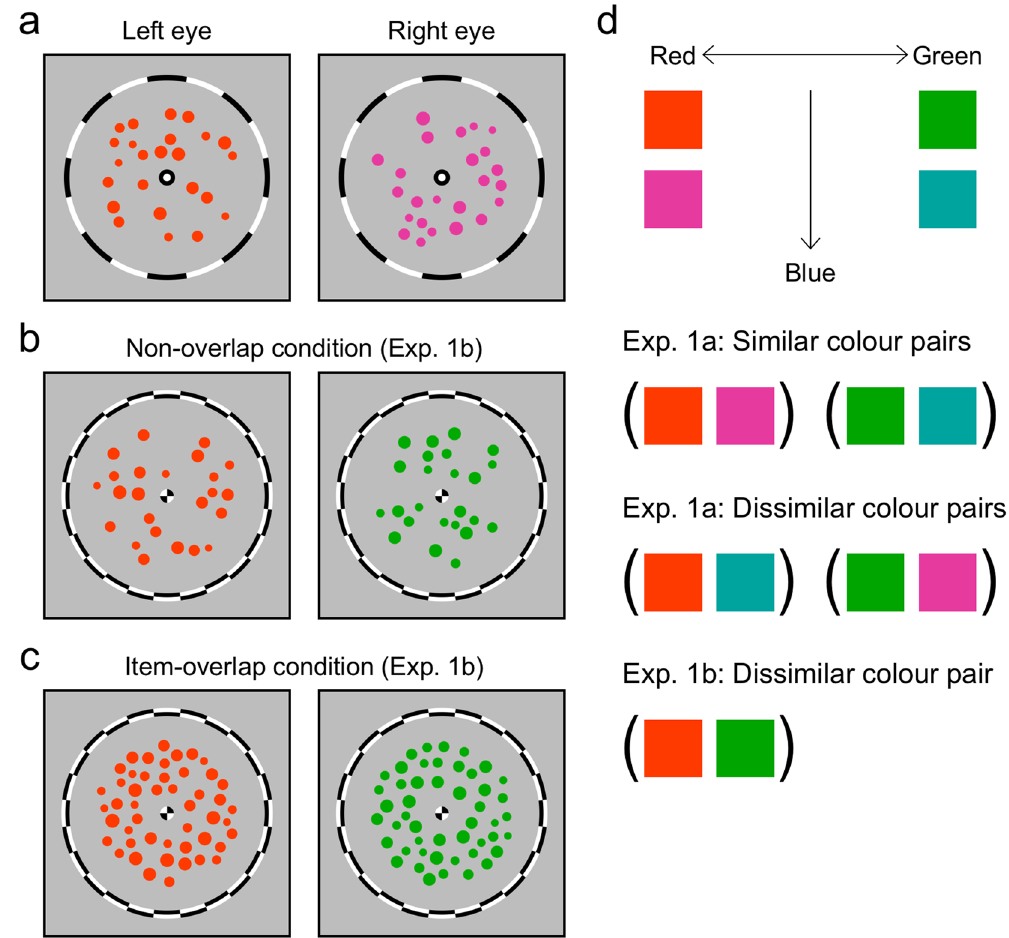
Figure 2. Example stimuli used in Experiment 1a are shown in ( a ), example stimuli of the non-overlap condition in Experiment 1b are shown in ( b ), and the item-overlap condition in ( c ). The colours of the circles in this figure are chosen to give a similar sense as the colours used in Experiments 1a and 1b. In the real Experiments, each participant adjusted colours so that they were subjectively equiluminant. We used two colours in the pure red-green scale and the other two colours made by adding a bit of blue to the pure red and pure green ( d ). Four pairs made from those four colours were tested in Experiment 1a. In Experiment 1b, only one pair of the pure red and pure green was